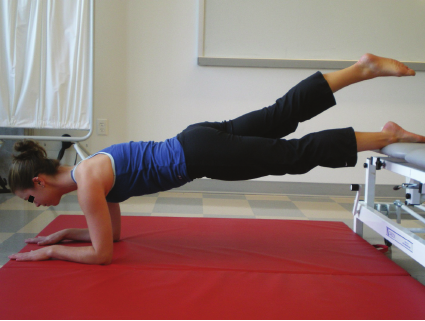
Figure 1: Anterior power line (APL).